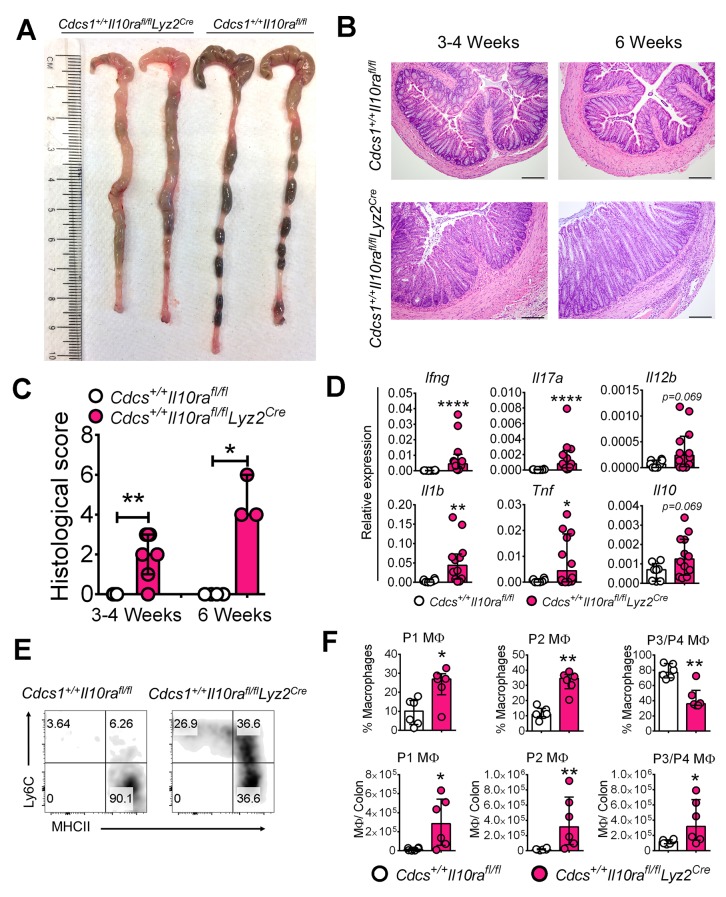
Macrophage-specific IL10Rα is necessary to prevent intestinal inflammation in infant mice.(A) Representative gross macroscopic images of colon from 6 week old mice. (B) Representative histologic images of distal colons of Cdcs1+/+Il10rafl/flLyz2Cre and littermate Cdcs1+/+Il10rafl/fl control mice (bar = 200 μm). (C) Histologic scores from indicated mice. (D) Colonic gene expression analysis by qRT-PCR. (E) Representative FACS plots; and (F) frequencies and numbers of colonic LP MΦ populations in the colons of 3–4 week old mice. *p<0.05, **p<0.01, ****p<0.0001, Mann-Whitney U test, Median with IQR is shown. Each data point indicates individual mouse, data were pooled from 2 to 3 litters resulting in a total of 4–12 mice in each group; whereas a representative of 2 litters is shown for 6 week old mice in A-C. Additional data file (Figure 6—figure supplement 1) showing the frequency and numbers of colonic CD4+ lymphocytes in 3–4 week old Cdcs1+/+Il10rafl/fl Lyz2Cre and littermate Cdcs1+/+Il10rafl/fl mice is provided.